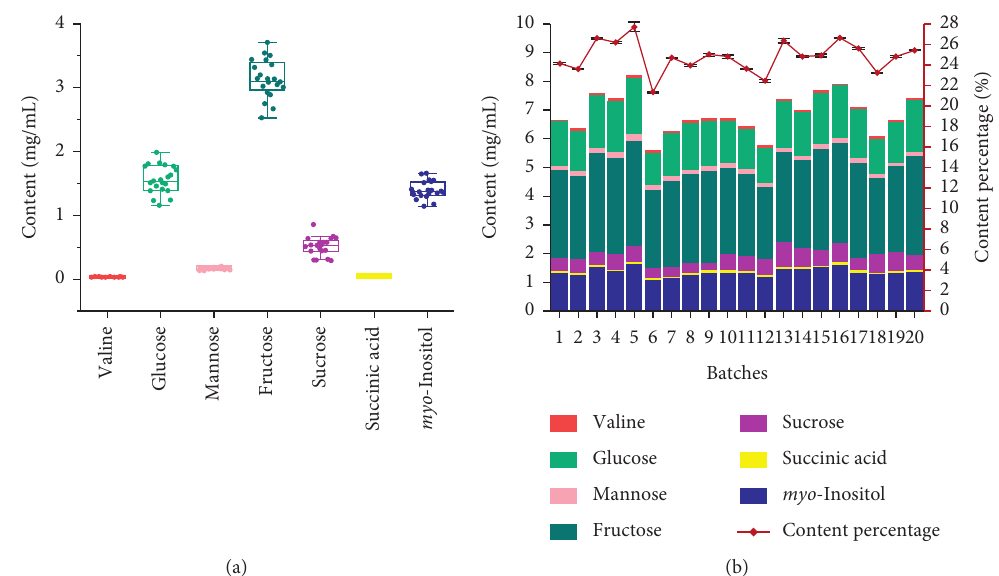
Figure 5: Boxplot for the quantitative analysis (a) and double-Y plot for the total content and content percentage (b) of seven primary metabolites in 20 batches SHLIs ( n �